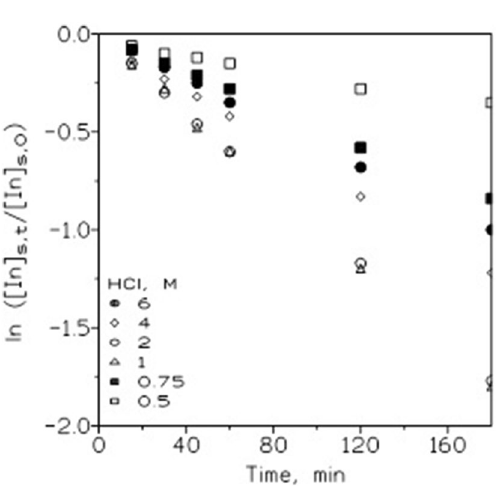
Figure 1. Influence of HCl concentration in the source phase on In(III) transport. The stirring speeds of the source and receiving phases were 750 and 500 min-1,